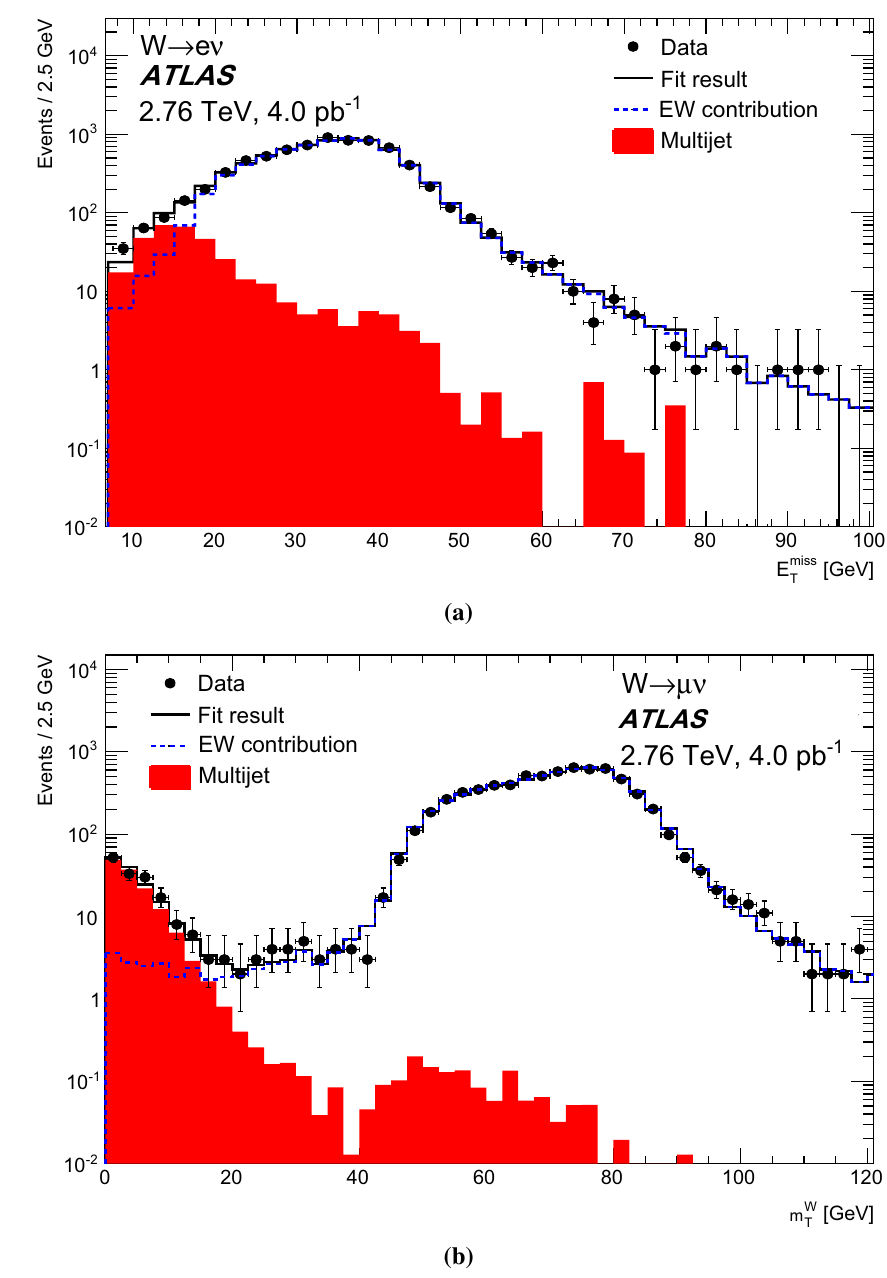
Fig. 1 Distributions used to estimate the multijet background contribution in (a) the W → e ν channel, and (b) the W → μν channel. The data is compared to the fit